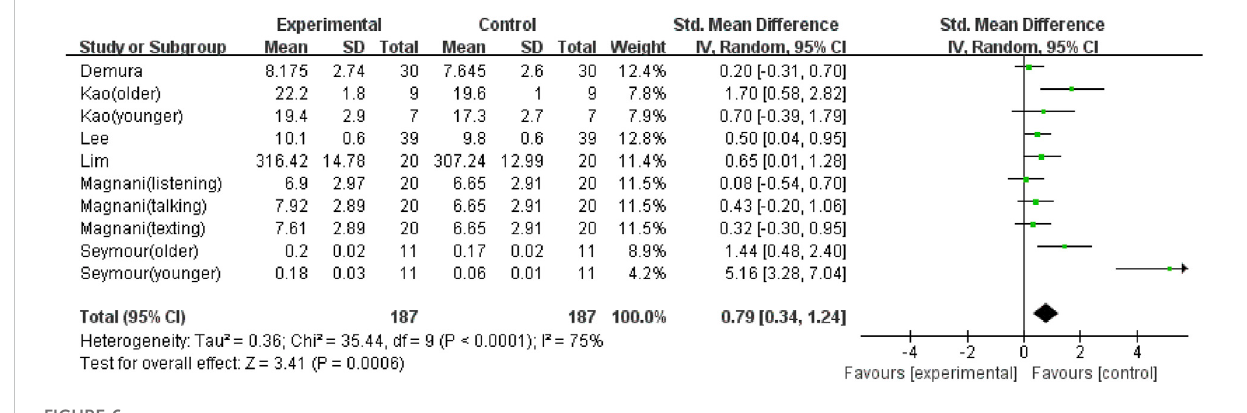
FIGURE 6 The effect of mobile phone use on step width.